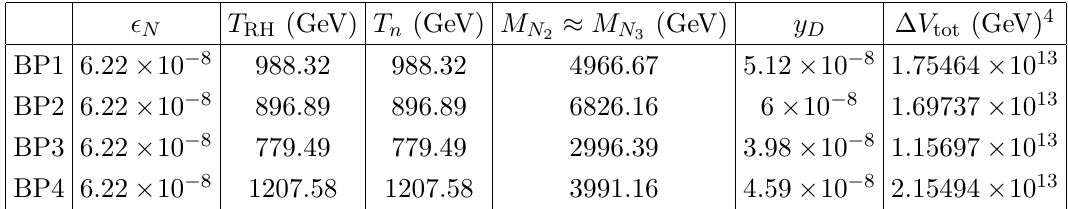
Table 4 . CP asymmetry and other relevant details involved in leptogenesis calculation for the hybrid